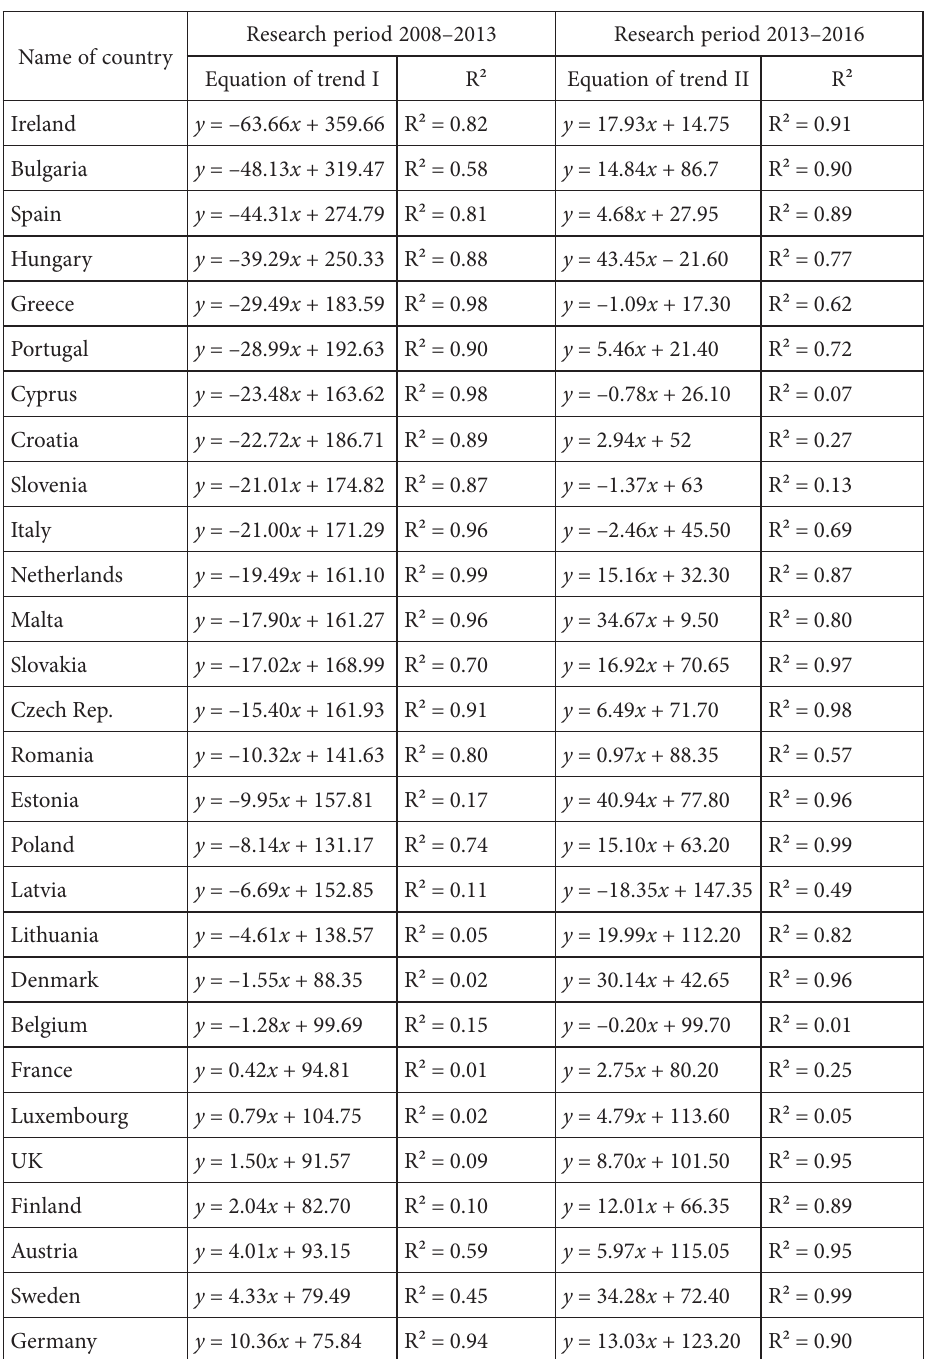
Table 3. Calculations pertaining to the issued building permits (source: author’s own